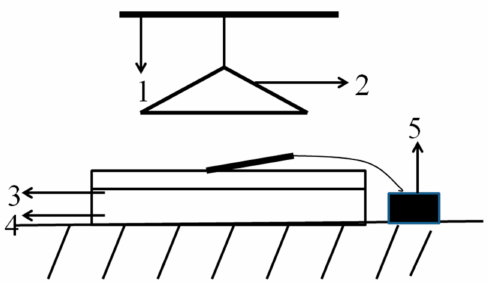
Figure 1. Experimental device for measuring the radiation-heating effect of the coating surface. 1—fixed devide; 2—275 W infrared lamp; 3—polysiloxane/Al coating; 4—substrate; 5—thermocouple